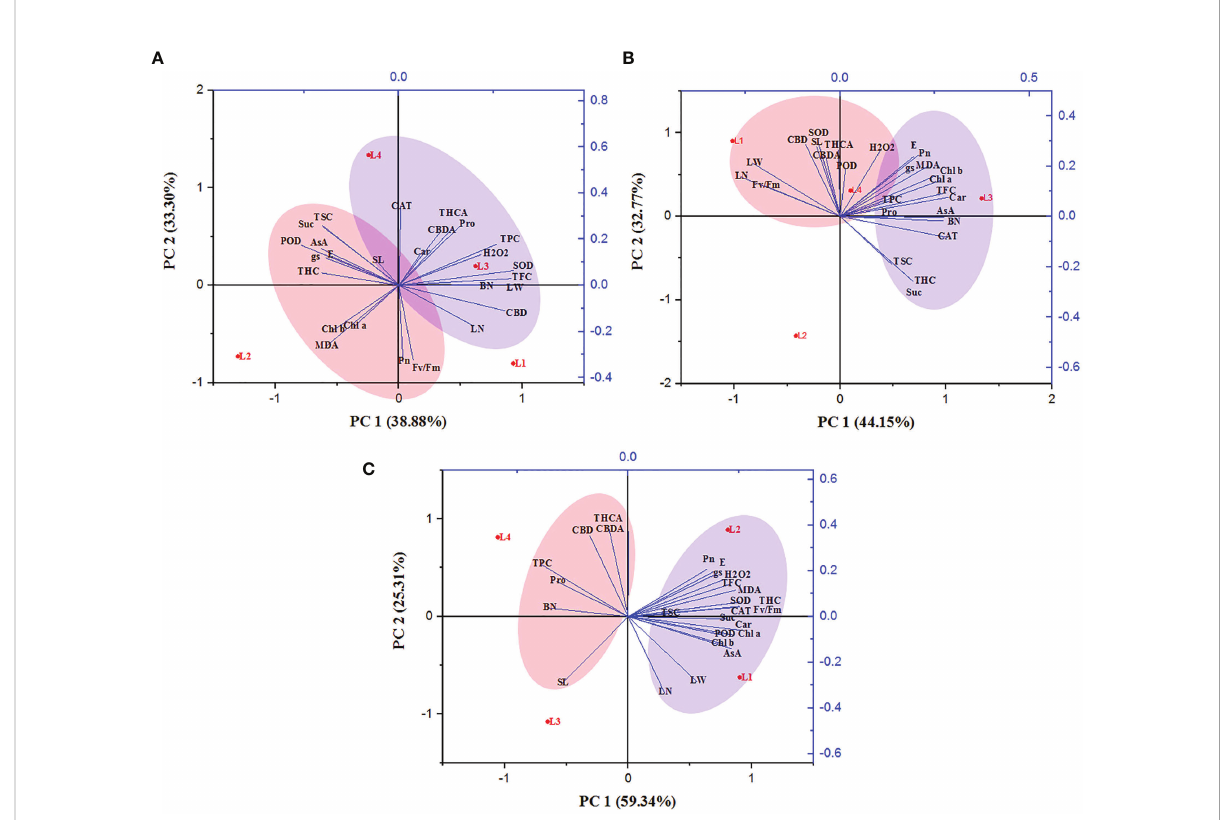
FIGURE 8 Principal component analysis of hemp seedlings under four LED light sources at 30 (A) , 60 (B) and 90 (C) DAT. The lines starting from the central point of the biplots display negative or positive associations of different variables, and their proximity speci fi es the degree of correlation with a speci fi c treatment. L1, MW 240 (Red 35% + Blue 25% + Green 40%); L2, FS 240-UV (Red 40% + UVA and Blue 26% + Green 29% + Far red 5%); L3, MB 240 (Red 85% + Blue 15%); L4, PF 240 (Red 70% + Blue 30%). SL, shoot length; BN, branch number; LN, leaf length; LW, leaf width; Chl a, chlorophyll a; Chl b, chlorophyll b; Car, carotenoid; Pn, photosynthetic rate; E, transpiration rate; gs, stomatal conductance; Fv/Fm, maximum photosynthetic ef fi ciency of PS II; H 2 O 2 , hydrogen peroxide; MDA, malondialdehyde; Pro, proline; AsA, ascorbic acid; TSC, total soluble carbohydrate; Suc, sucrose; TPC, total polyphenol content; TFC, total fl avonoid content; SOD, superoxide dismutase; CAT, catalase; POD, guaiacol peroxidase; THC, tetrahydrocannabinol; THCA, tetrahydrocannabinolic acid; CBD, cannabidiol; CBDA, cannabidiolic